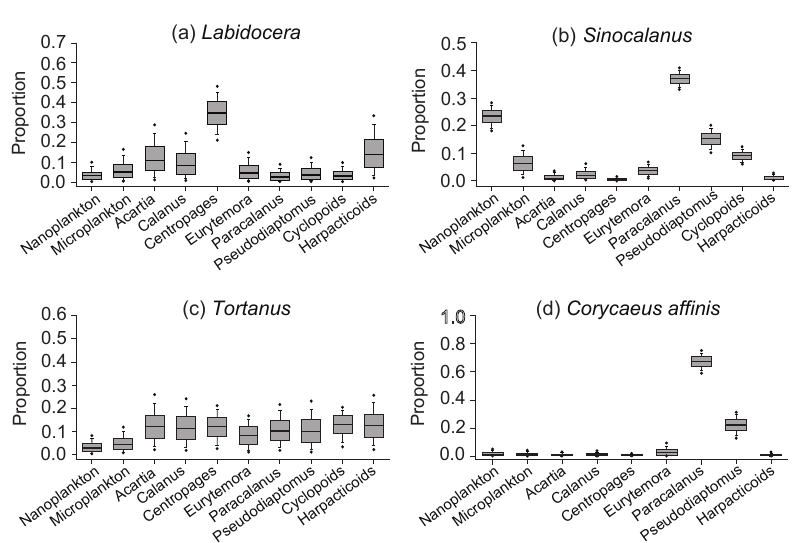
Figure 8. Comparison of the dietary composition of major carnivorous genera. Credibility intervals of 95% (dots), 75% (whiskers), and 25% (boxes) and mean values (lines in the boxes) are shown in box plots for each